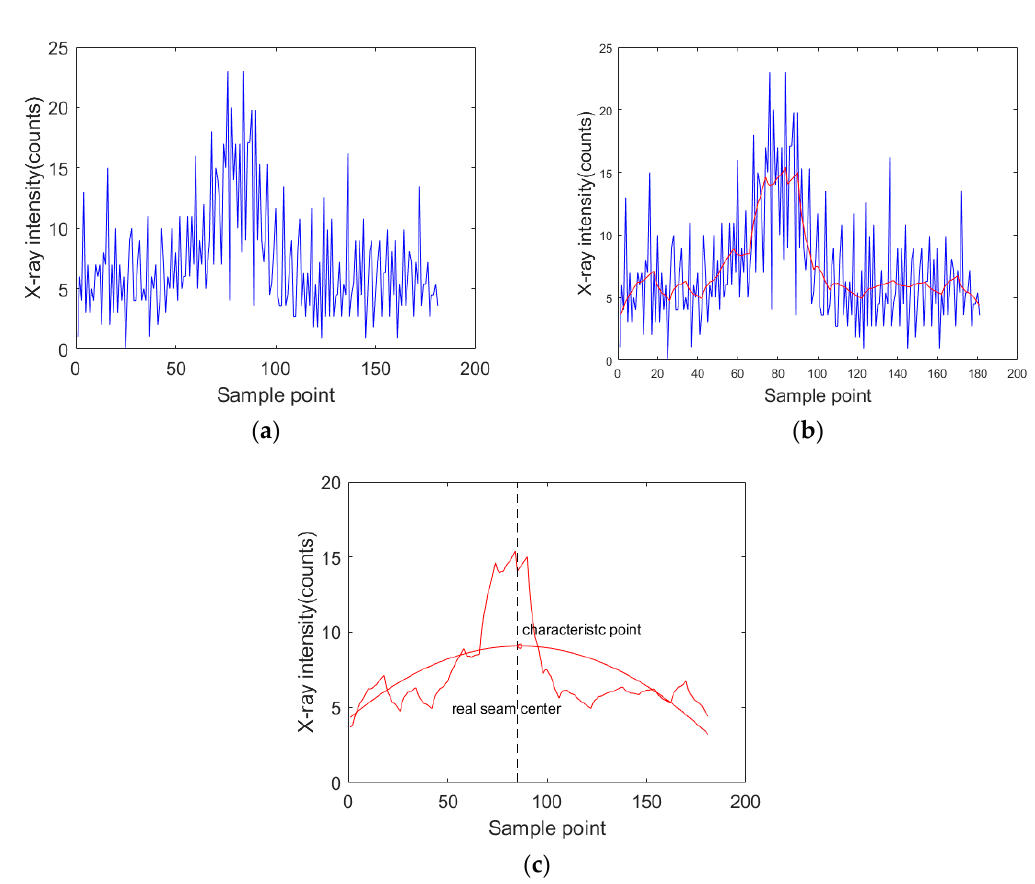
Figure 18. The processing procedure of X-ray intensity signal at a sampling frequency of 200 Hz: ( a ) read signals in a single scanning period; ( b ) denoising; ( c ) curve fitting.